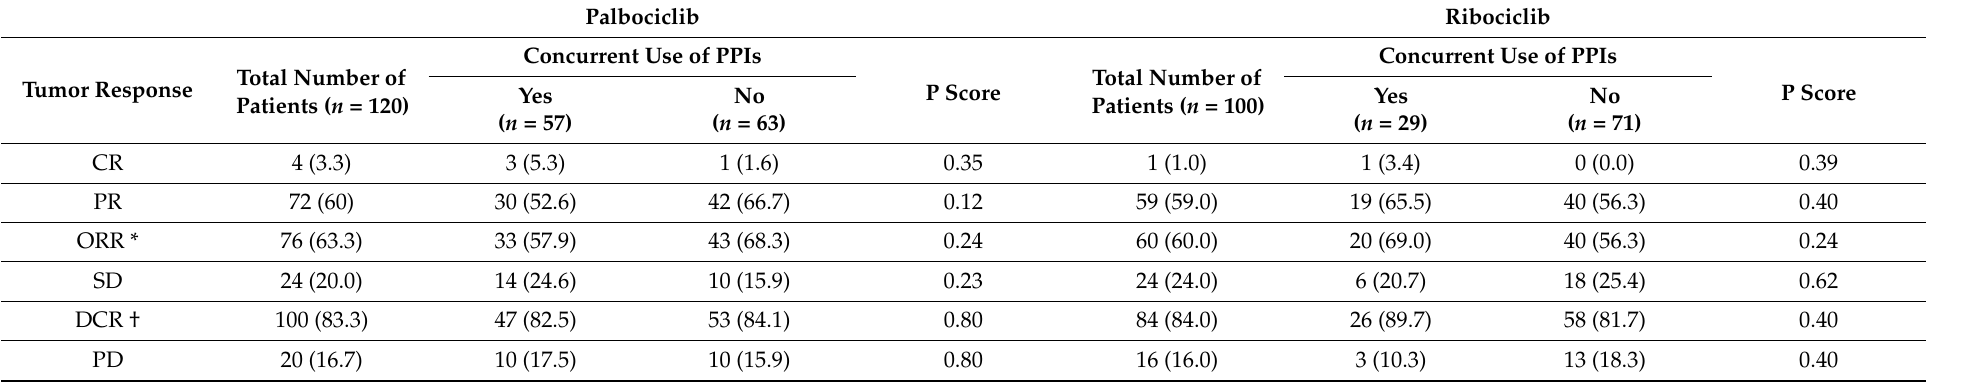
Table 4. Overall tumor